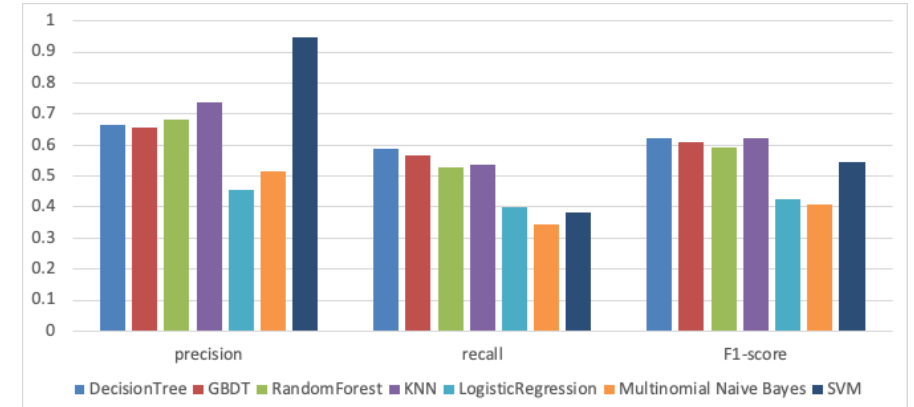
Figure 11. Results of various classification models that are applied in the machine learning recovery